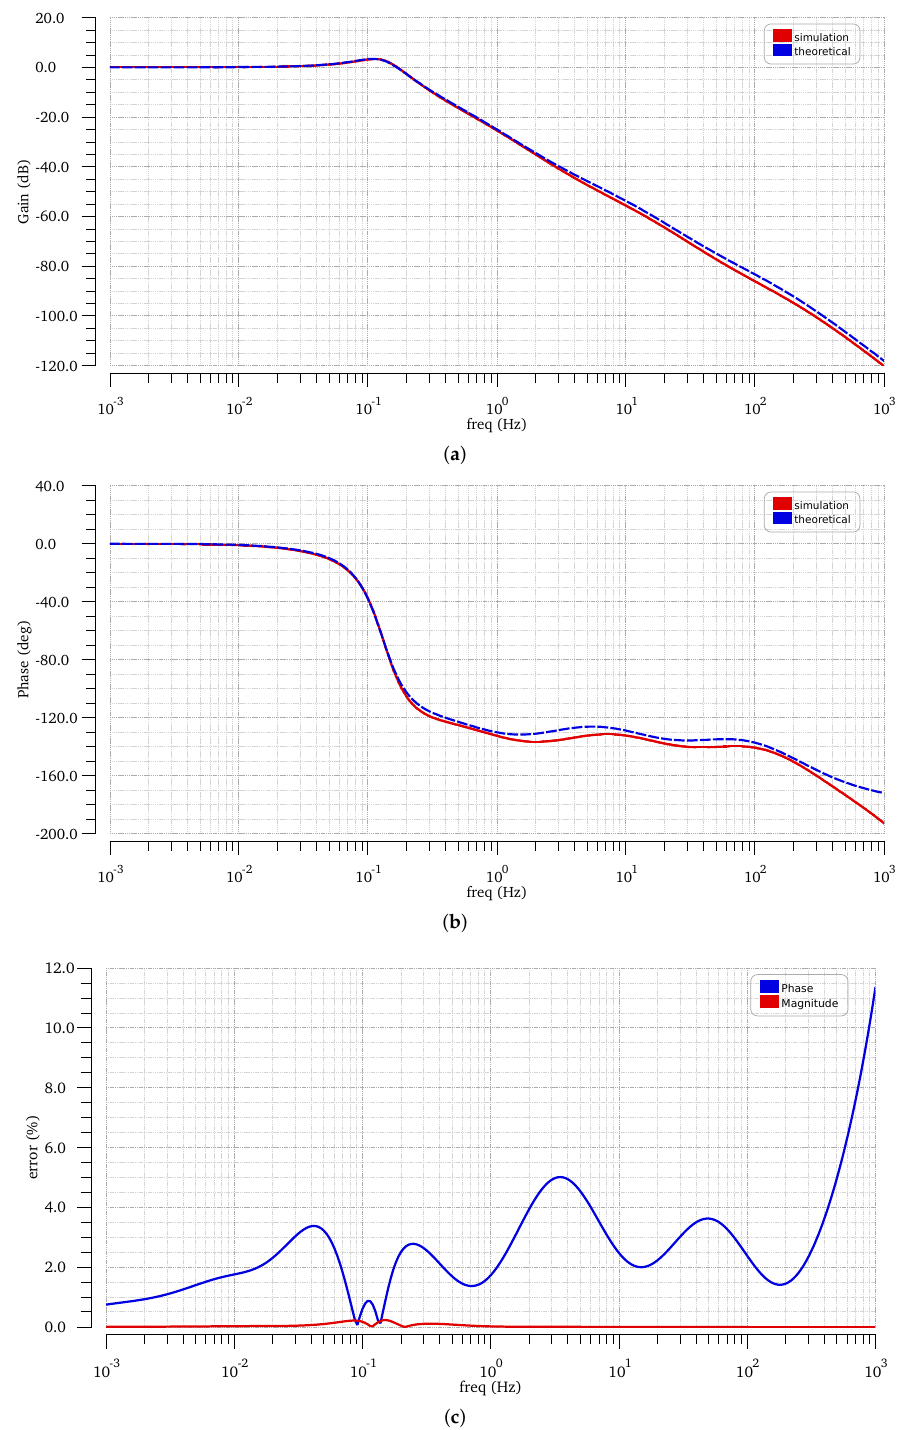
Figure 8. Frequency responses of ( a ) magnitude, ( b ) phase, and ( c ) error of magnitude and phase of the closed-loop controller-plant